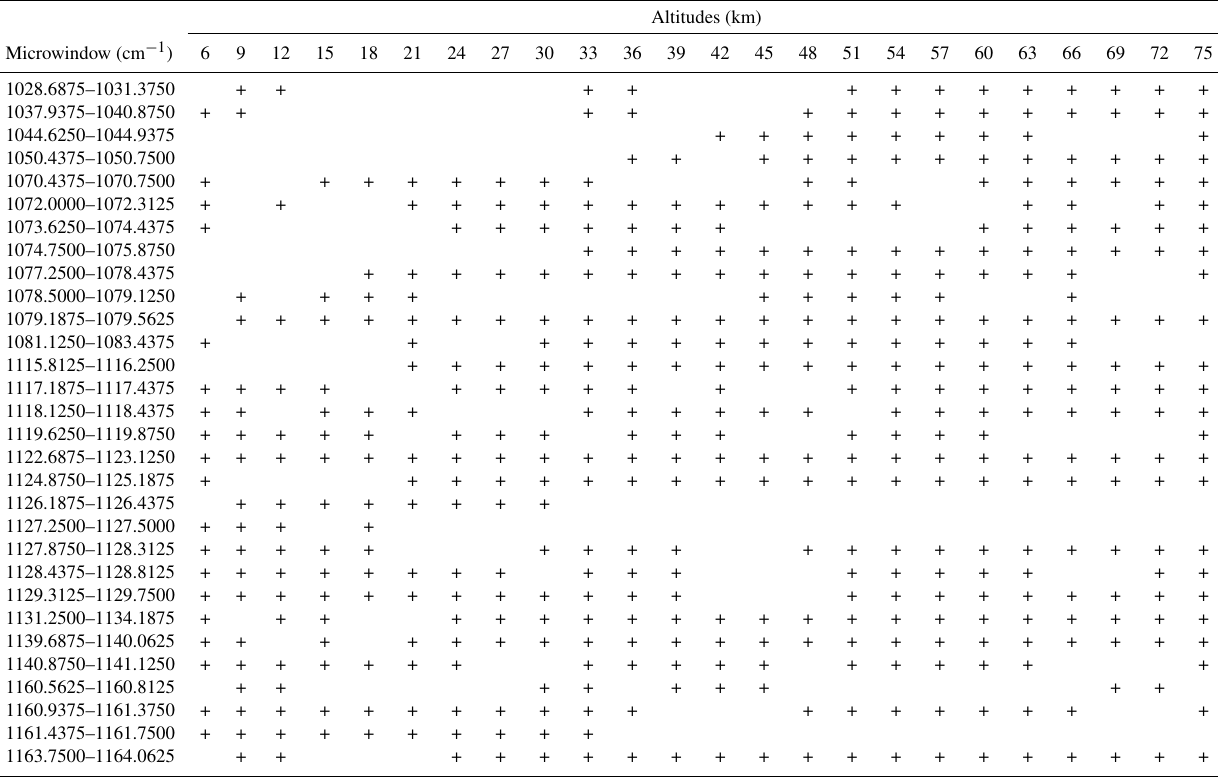
Table 2. Microwindow set used for ozone retrieval in MIPAS channel AB. The left column shows the spectral ranges of the microwindows. The plus signs indicate at which heights a particular microwindow is